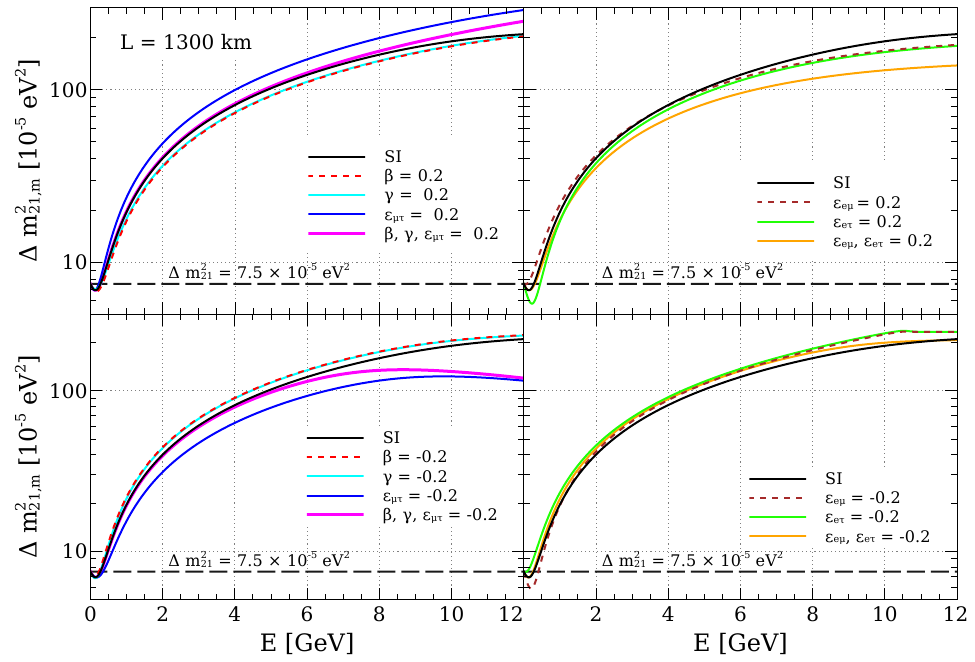
( ≡ m 2 ) as obtained from eqs. (5.1)–(5.3) is shown with Figure 7 . Variation of ∆ m 2 − m 2 21 ,m 2 ,m 1 ,m energy in SI case and SI+NSI cases. Top (bottom) row corresponds to the positive (negative) NSI with strength 0.2. The solid black curve in each panel shows the SI case while the other curves show the modification in presence of NSI. The left column depicts the presence of various NSI parameters in (2,3) block while the right shows the effect of ε and ε . We consider L = 1300 km and the eµ eτ values of the oscillation parameters used in this plot are taken from table 2. We assume θ = 45 ◦ 23 and